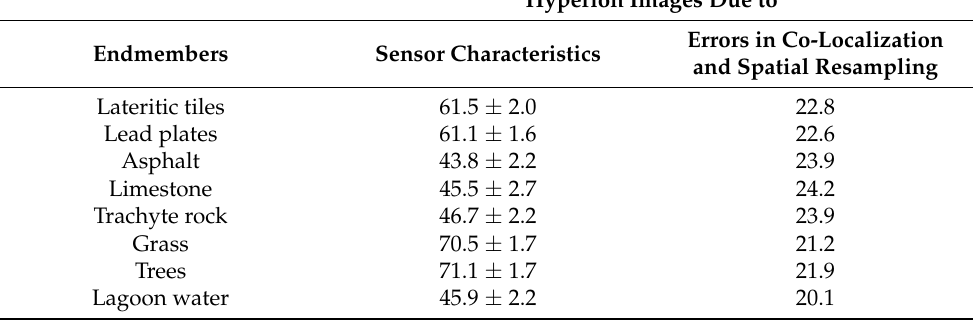
Table 6. The percentage of MAE k-Totals values due to the PRISMA sensor characteristics added to the error in the simulation of real data and the percentage of MAE k-Totals values due to errors in co-localization and spatial resampling of the